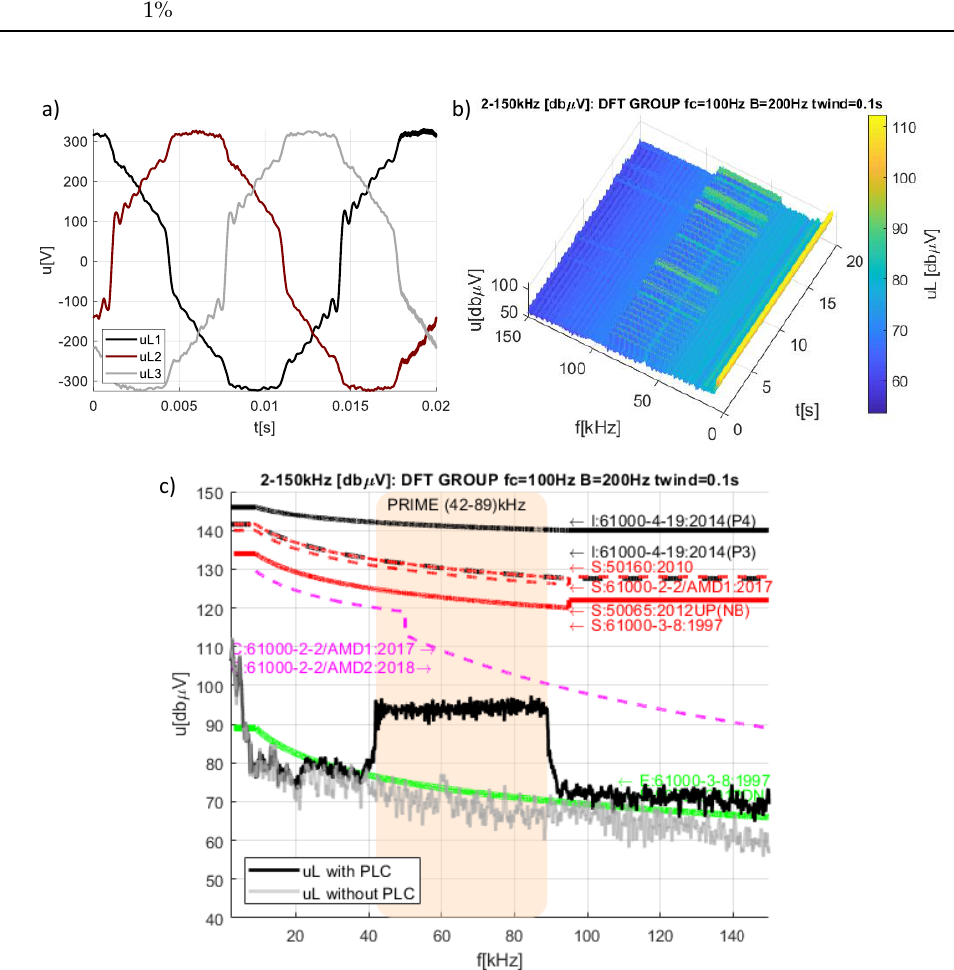
Figure 9. Case 3: results of the analysis of PRIME PLC system operation with LED light sources at distorted supply voltage referring to permissible limits for public grid defined in EN 50160:2015 [3]; ( a ) supply voltage waveform; ( b ) time-frequency representation in the range 2–150 kHz using 100 ms window during the 20 s observation; ( c ) comparison of the spectrum of the corresponding PRIME PLC transmission (black) and the spectrum of the voltage in the connection point of the load (grey) with the relation to the normative curves (uL—line voltage in the point of the equipment connection, which is also the point of energy meter connection with PRIME PLC).